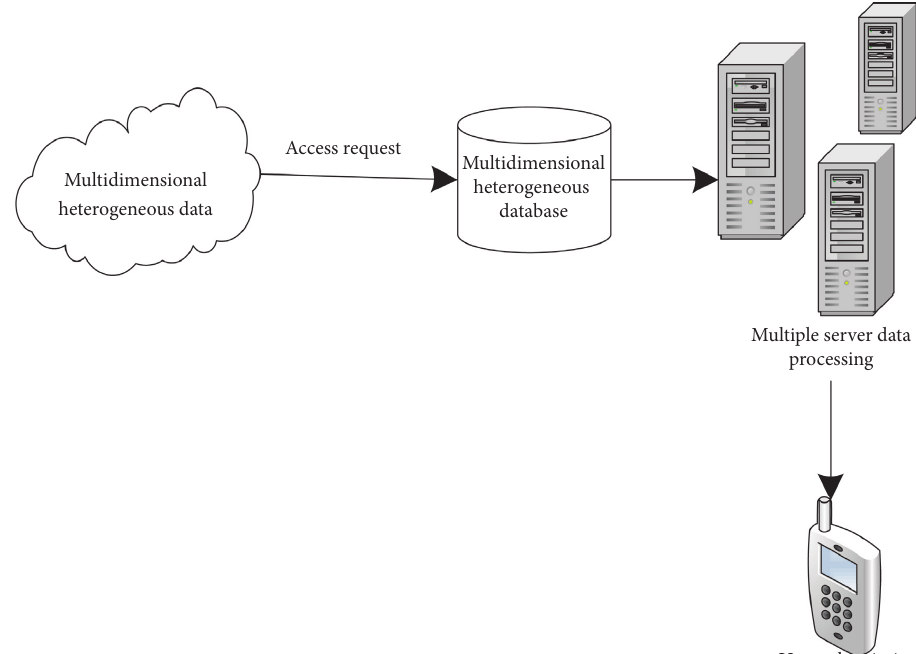
Figure 2: Design of data push